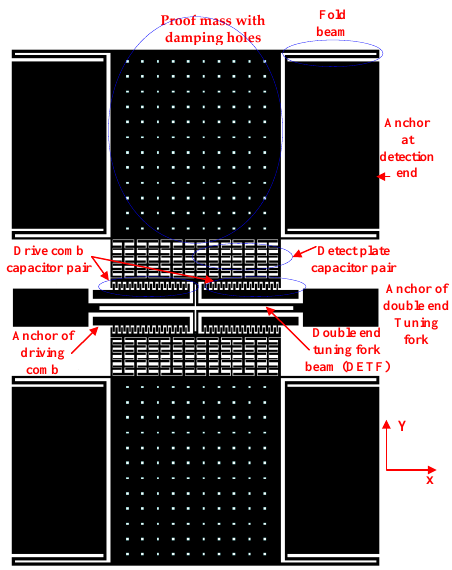
Figure 1. Structural diagram of an accelerometer.